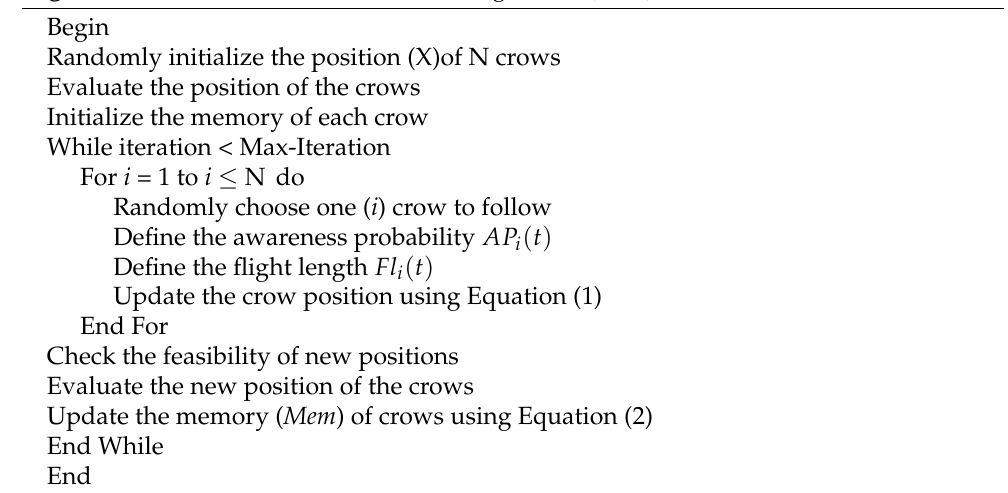
Algorithm 1 The Standard Crow Search Algorithm